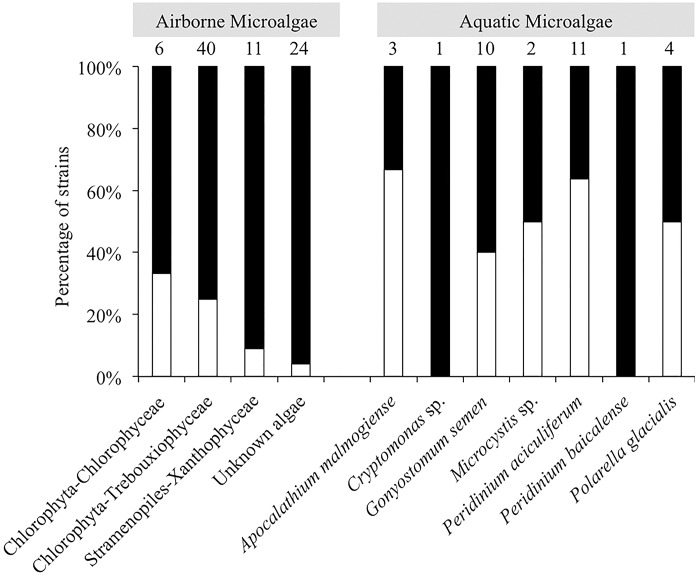
Percentage of airborne strains (class level) and aquatic strains (genus level) of microalgae that were INA (white bars) or were inactive (black bars).